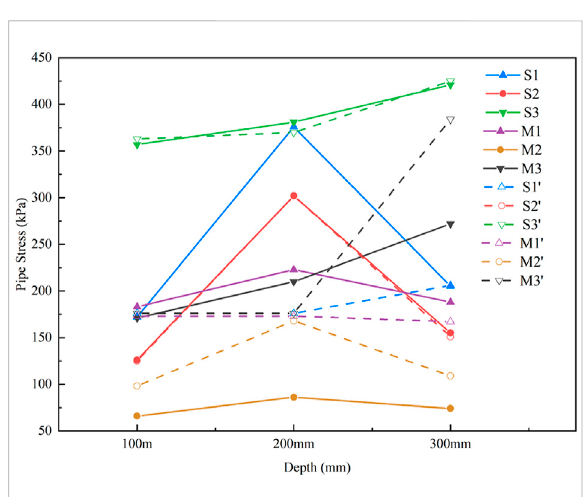
FIGURE 17 Stressofpipelineatdifferentburieddepthsunder6 kPaloads.